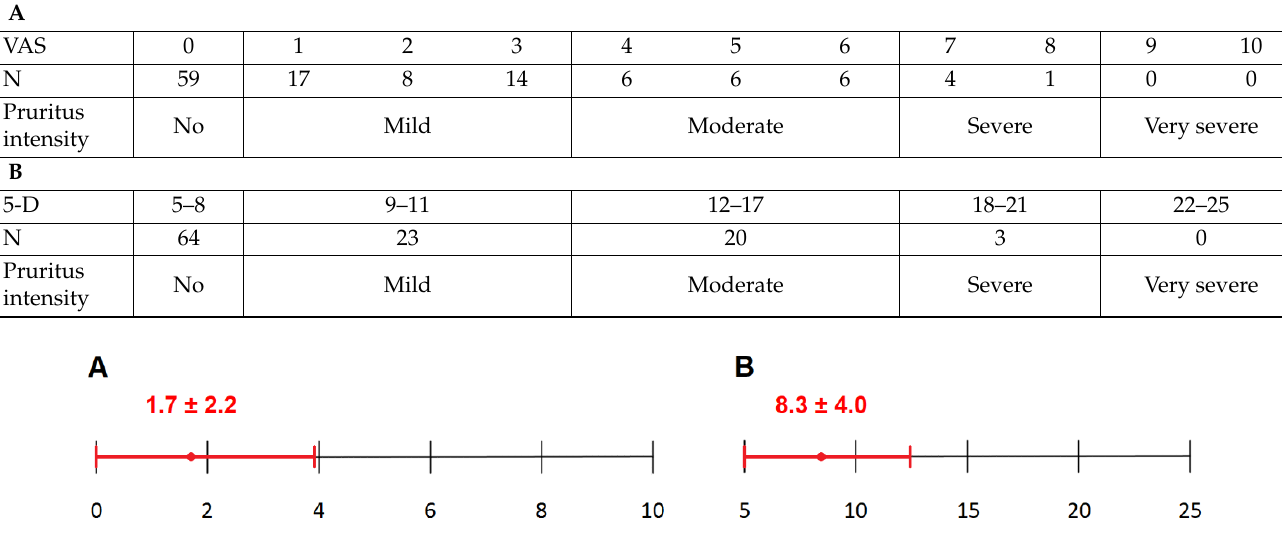
Table 4. Distribution of the VAS (A) and 5-D itch scale (B) results. Values are frequencies.